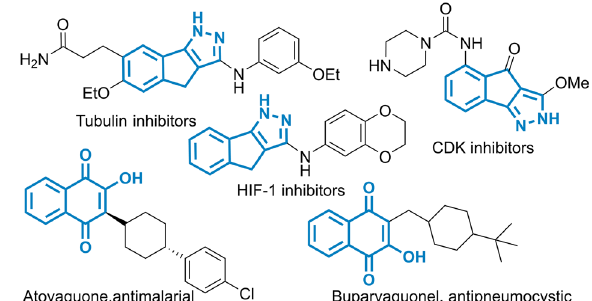
Fig. 1 Regiochemistry of the ring expansion of cyclic ketones. a The selective ring expansion of isatins. b This work, the selective ring-expansion of indantrione.